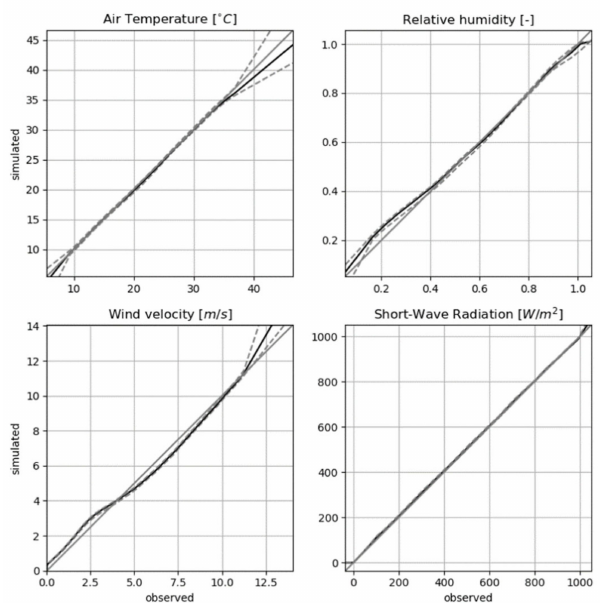
Figure 3. Quantile–quantile plots for air temperature, relative humidity, wind velocity and short-wave radiation in the Unchanged scenario. Dashed lines show ranges of all realizations of the Unchanged